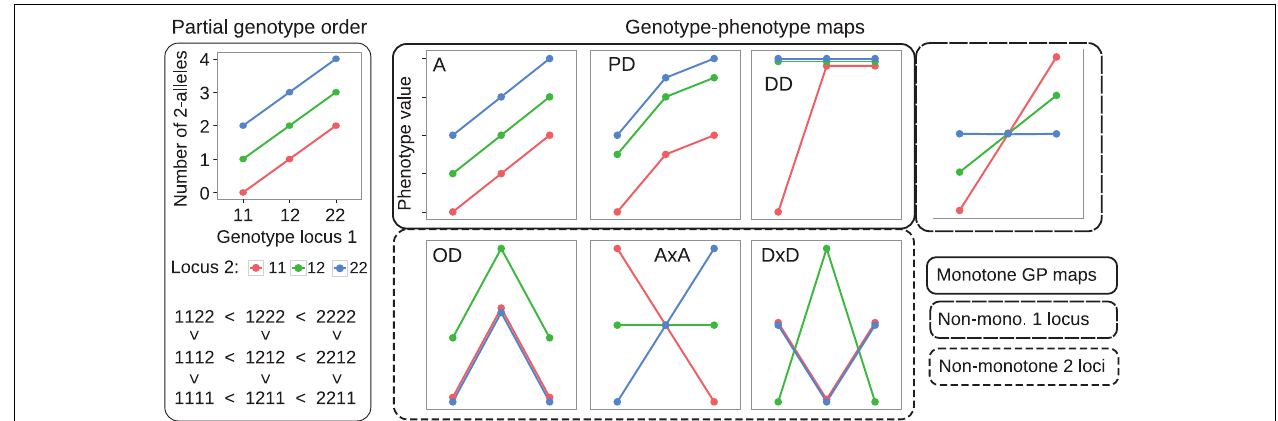
FIGURE 1 | Examples of partial genotype order and genotype-phenotype maps. Left panel : The allele content defines a partial order on genotype space. A two-locus example is shown. The plot at the top displays the genotype at locus 1 (x-axis) and locus 2 (color) vs. the total number of 2-alleles (y-axis) in the two-locus genotype. The resulting partial ordering of genotypes is shown below. Right panel: Each lineplot shows the 9 genotypic values (y-axis) for a single GP map, coding of genotype are the same as in the left panel. GP maps that preserve the partial order of